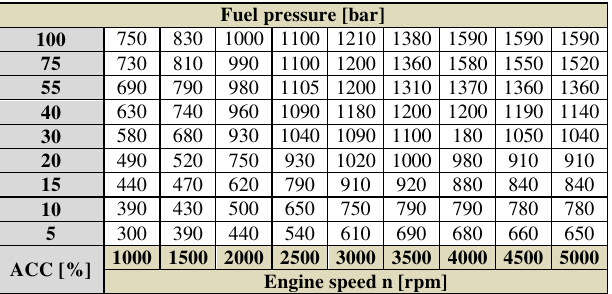
Table 8. Control algorithm of fuel pressure in Common Rail at dual fuel supply of the engine